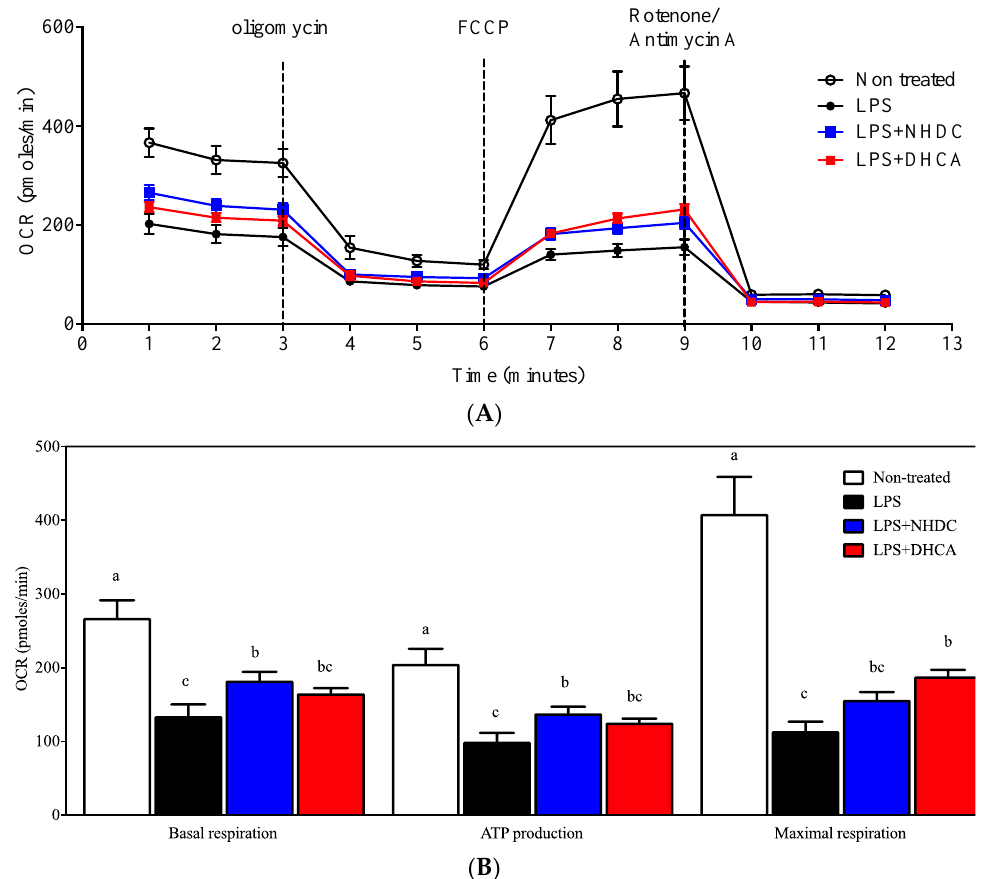
Figure 2. Mitochondrial respiration measurement by OCR. Mitochondrial respiration of RAW 264.7 macrophages was determined using a Seahorse extracellular flux analyzer by OCR (OCR, oxygen consumption rate). ( A ) Real-time OCR value of cells with NHDC or DHCA, with several drugs to regulate mitochondrial respiration. ( B ) Several respiration indices calculated by OCR, including basal respiration, maximal respiration, and ATP production. a–c Statistically significant values ( p < 0.05) are displayed with different